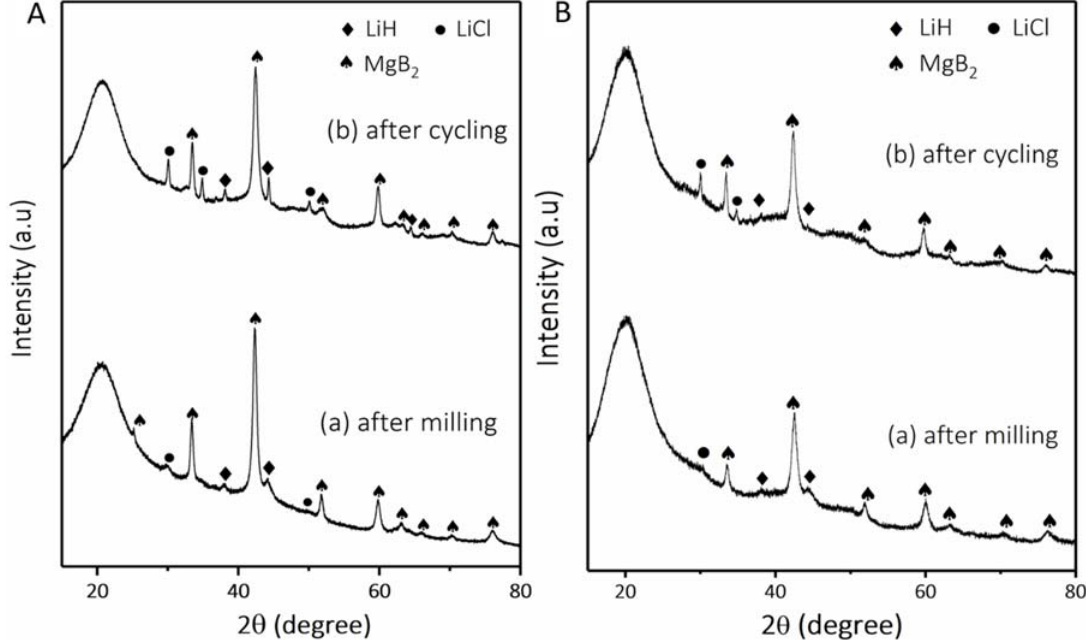
Figure 6. XRD patterns of the composites A Li ‐ RHC d +7.5(3TiCl 3 ∙ AlCl 3 ): (a) after milling and (b) after + 7.5(3TiCl · AlCl TM : (a) after milling and (b) after cycling; and B Li ‐ RHC d +7.5(3TiCl 3 ∙ AlCl 3 ) with TPX TM : (a) after milling and (b) after cycling. cycling; and ( B ) Li-RHC d 3 3 ) with TPX